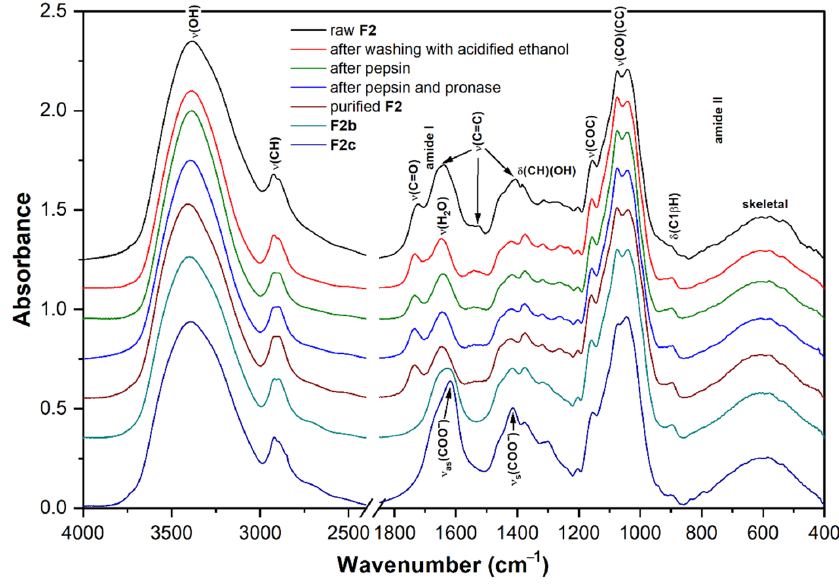
Figure 5. FTIR spectra of the successively purified fraction F2 and derived sub-fractions F2b and F2c .